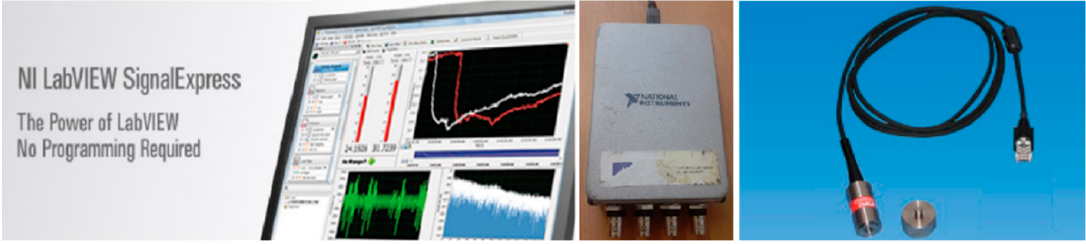
Figure 8. The NI LabVIEW SignalExppress software and the CMLV 3850 accelerometer.